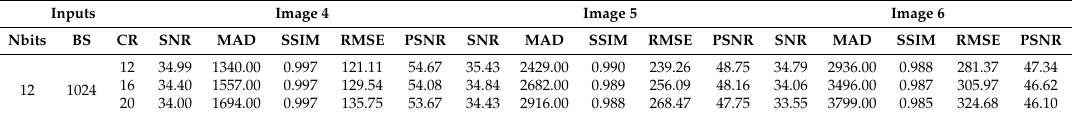
Table 4. Compression Results. Achieved SNR, MAD, SSIM, RMSE and PSNR for Image 4, Image 5 and Image